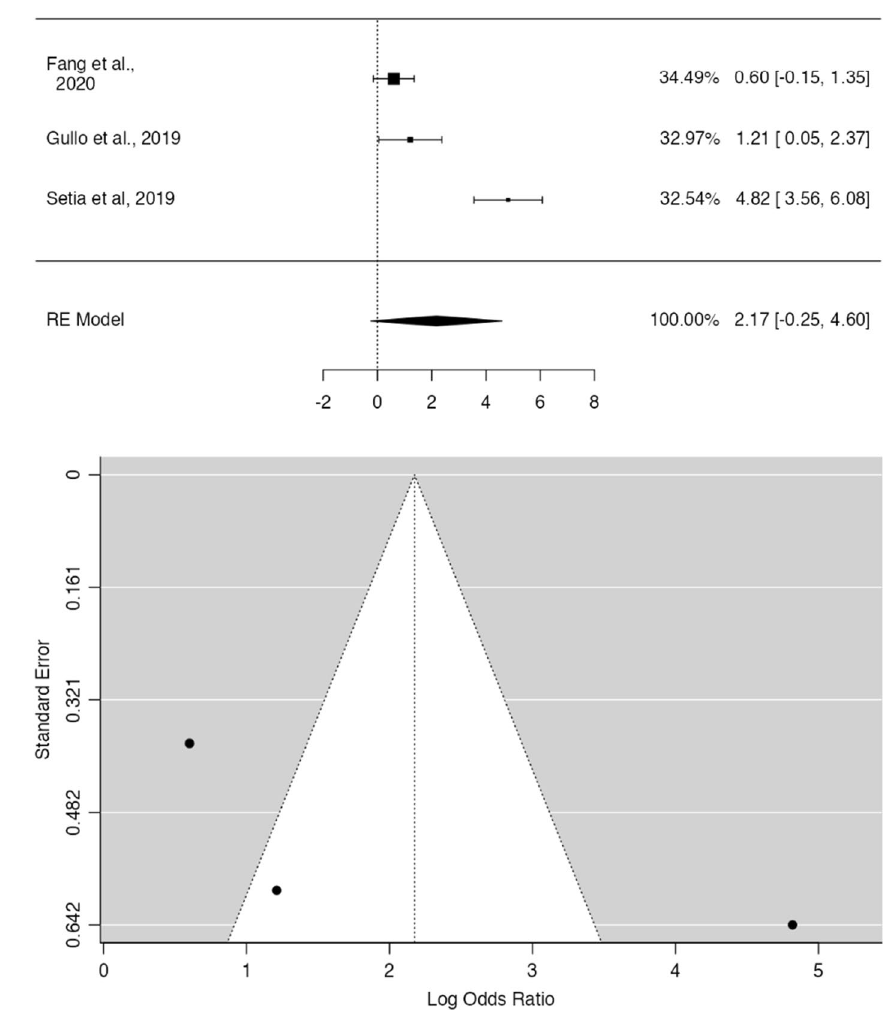
Fig. 12 Forest-plot describ- ing the association between PD-L1 and GCLS. Logarithm for OR is represented in the forest-plot